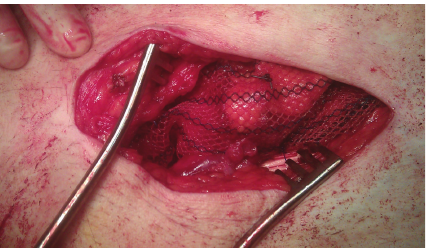
Figure 4: Restoration of the abdominal wall using a mesh according to